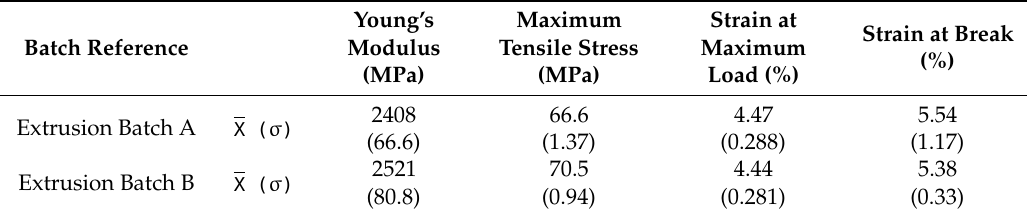
Table 5. Summary of tensile properties of Batch A and B extruded